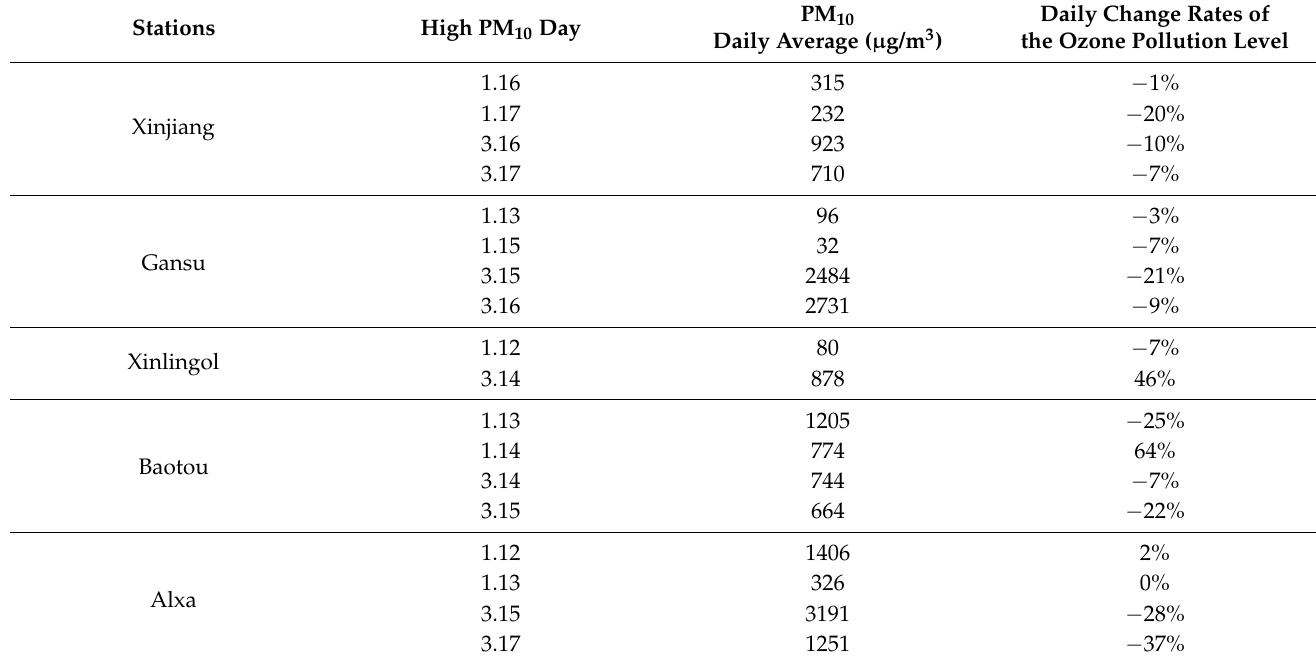
Table 2. Variation of ozone pollution levels in sand source sites during the 1.12 and 3.15